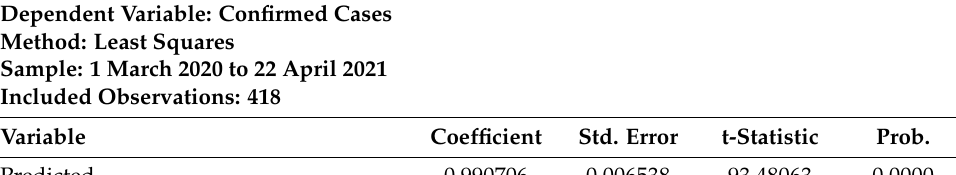
Table 3. Test results of the predictive capability of a linear model of confirmed cases in Saudi